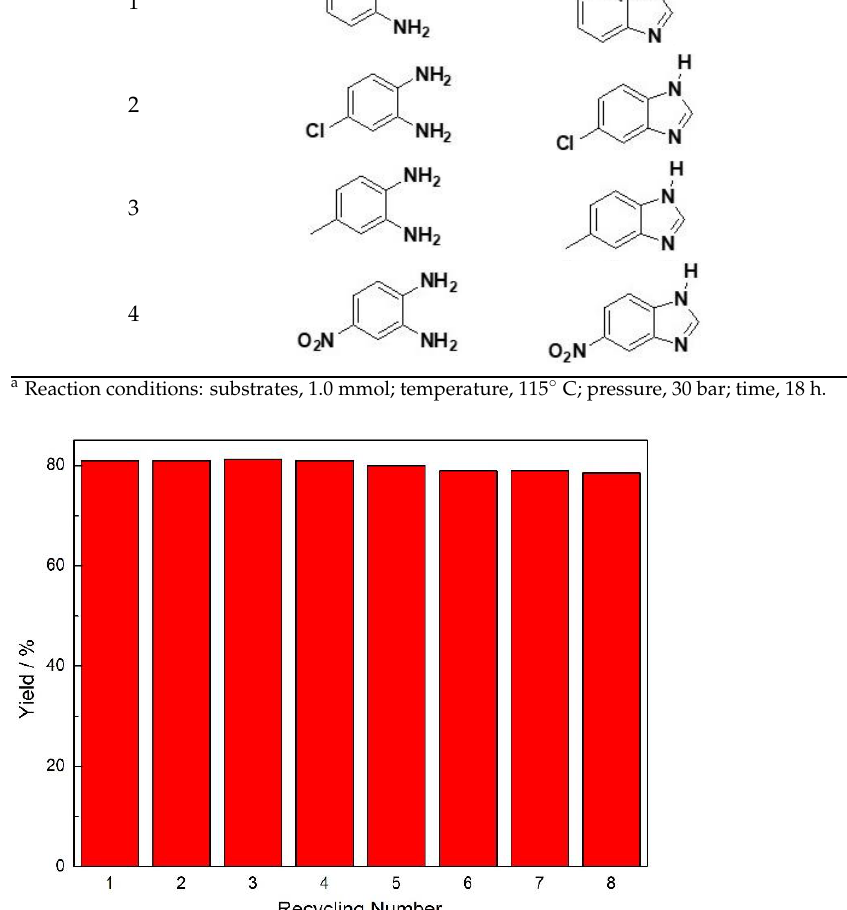
Figure 5. Influence of ( a ) temperature; and ( b ) reaction time on the yield of benzimidazole. Reaction conditions: o -phenylenediamine, 1.0 mmol; pressure, 30 bar; CoNi@C, 100 mg. Table 2. CoNi@C-catalyzed synthesis of various benzimidazoles a . Entry Substrate Product Yield Entry Substrate Product Yield Entry Entry 1